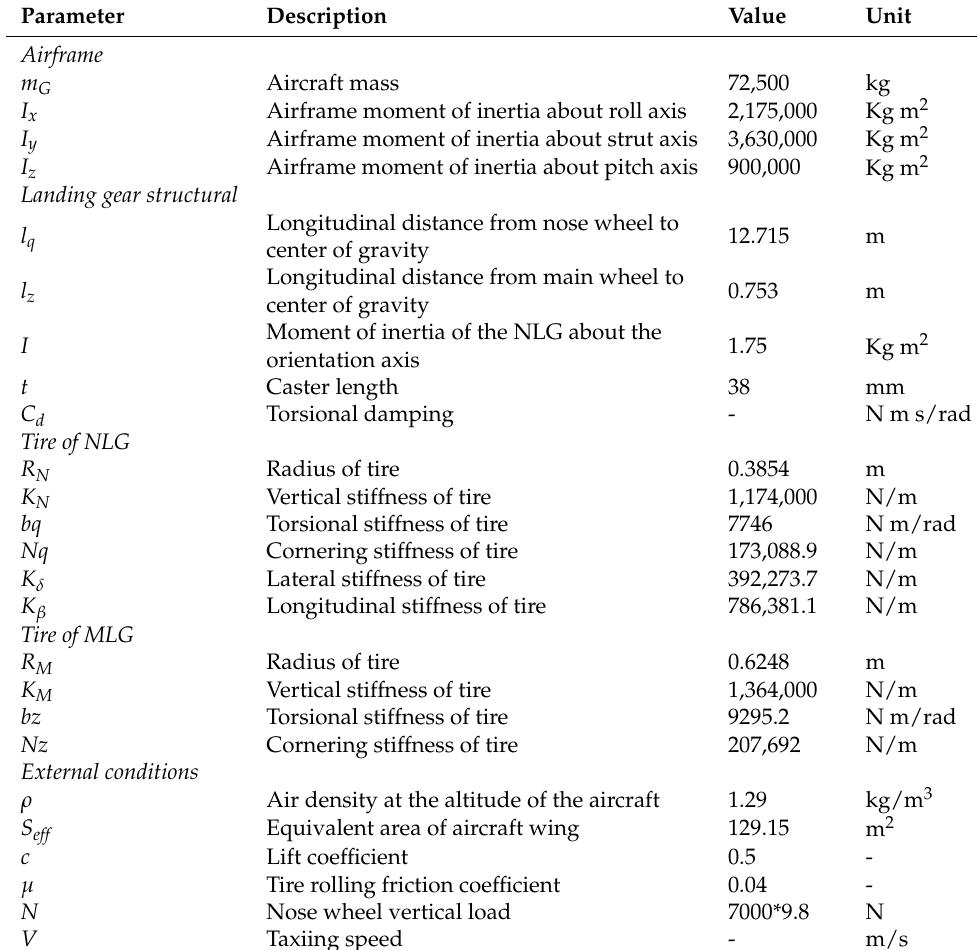
Table 3. Main parameters of airframe and landing